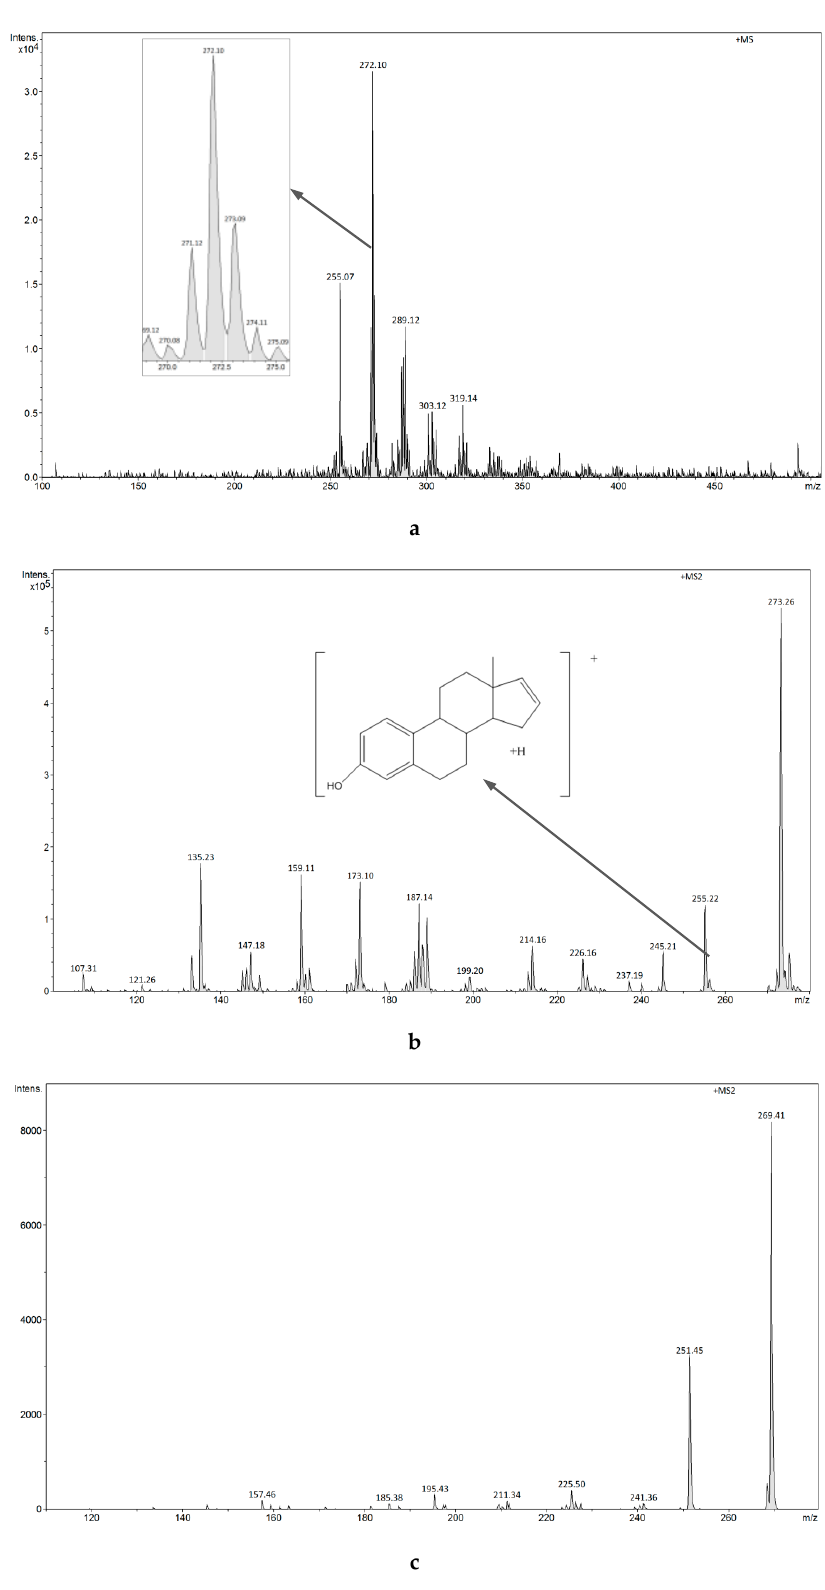
Figure 11. ( a ) FAPA-MS (positive ions) spectrum of E2. ( b ) FAPA-MS 2 fragmentation spectrum of the m / z 273 ion observed for E2. ( c ) FAPA-MS 2 fragmentation spectrum of the m / z 269 ion observed for